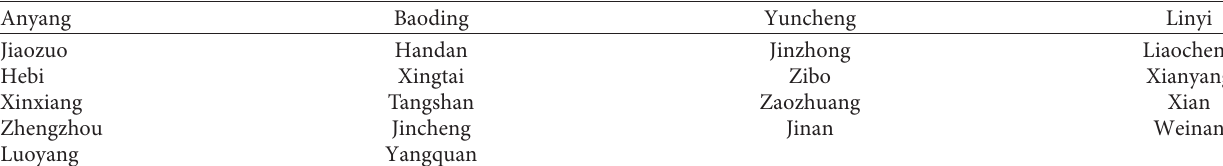
Table 1: Research